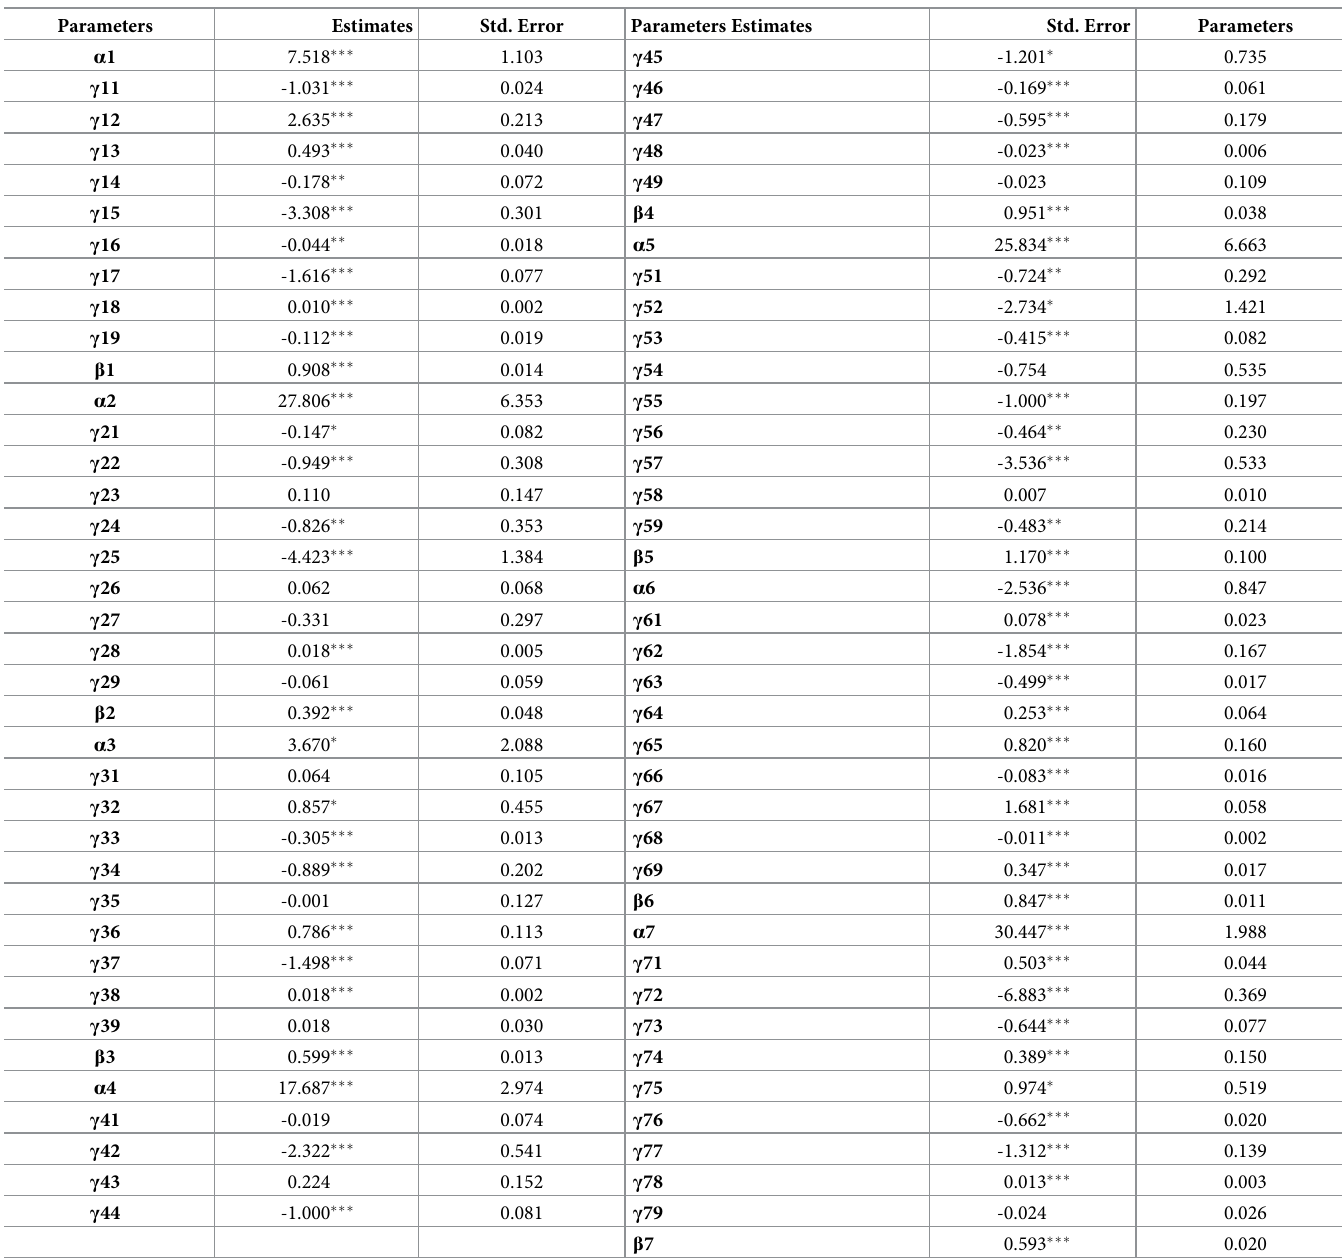
Table 2. Uncompensated double-log demand